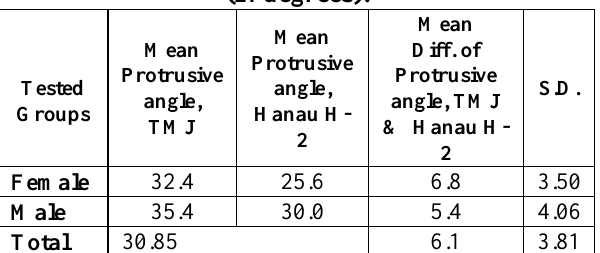
Table 3: Descriptive Statistics of the Difference of Protrusive Angle Mean Values Verified by TMJ & Hanau H-2 Articulators (in degrees).